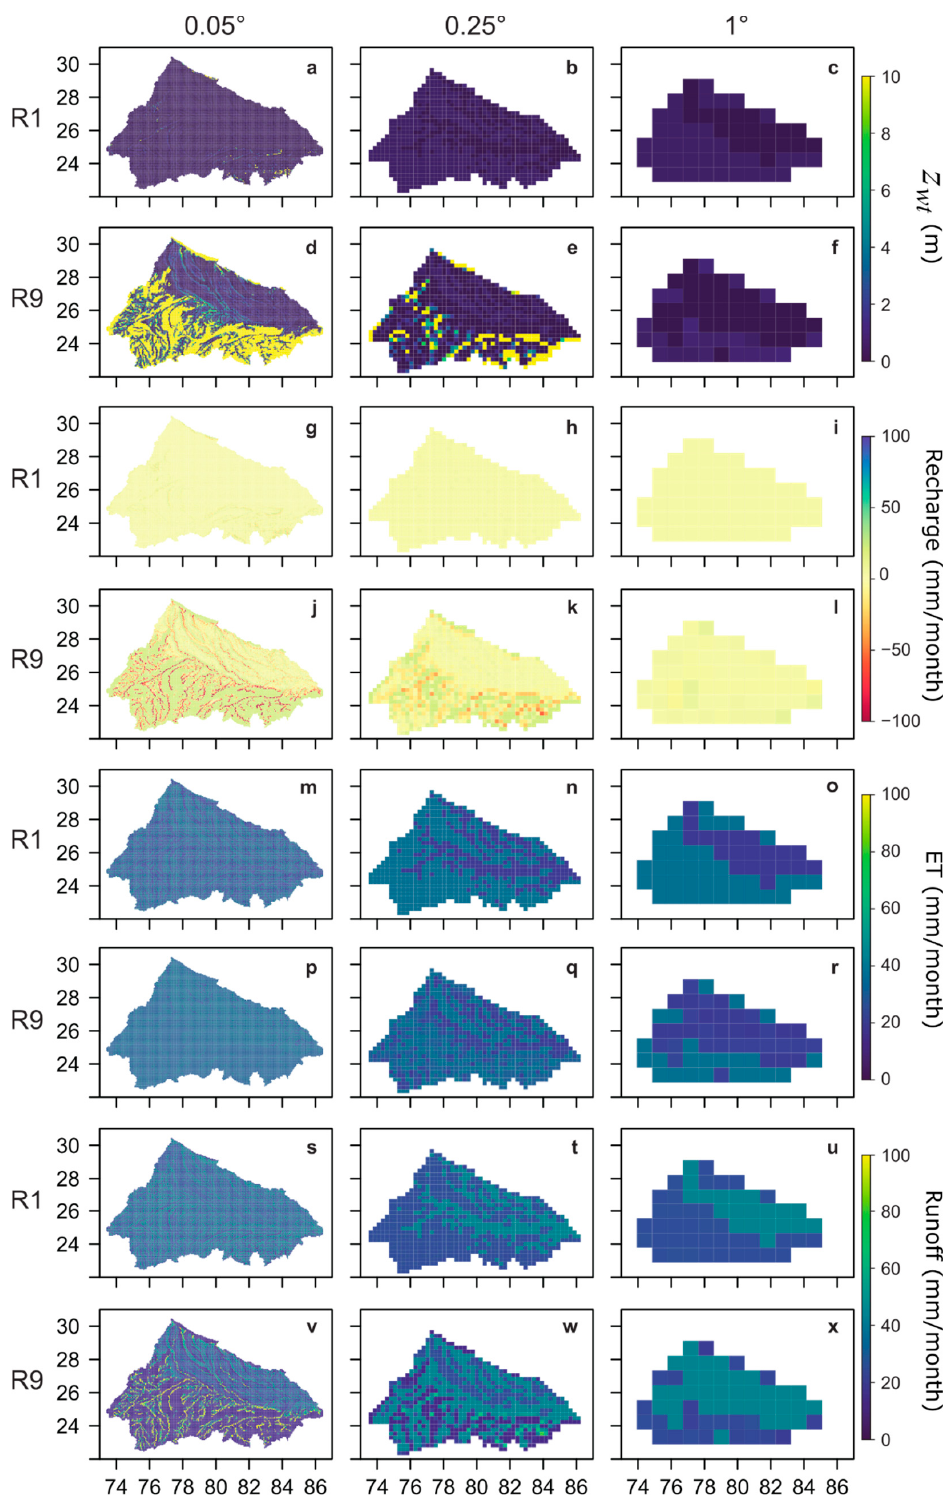
Figure 4. Mean values of water table depth ( a – f ), groundwater recharge ( g – l ), ET ( m – r ), and runoff ( s – x ) for R1 (low T , low S ) and R9 (high T , high S ) models, and three grid resolutions 0.05 ◦ , 0.25 ◦ and 1 ◦